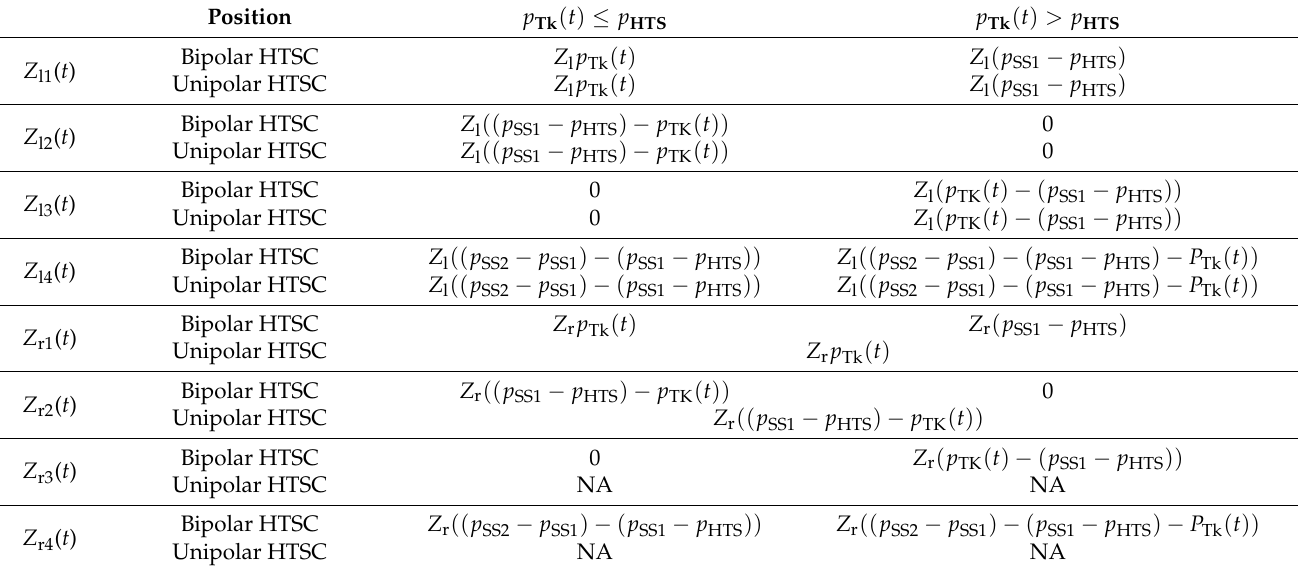
Table 2. Expression of the different linear impedances Z ( Ω /km) as a function of train position p Tk